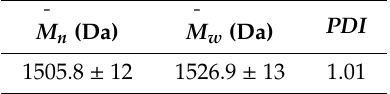
Table 4. Average molecular weight and polydispersity index.